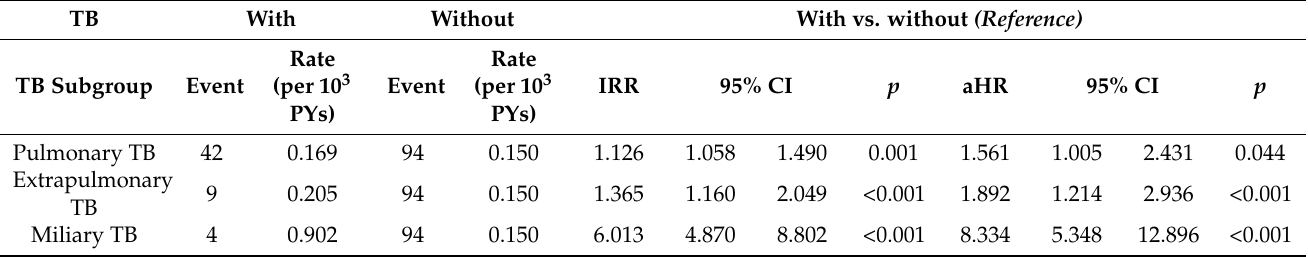
Table 4. Incidence and aHR for aortic aneurysm and aortic dissection in the TB and non-TB cohorts stratified by TB type.